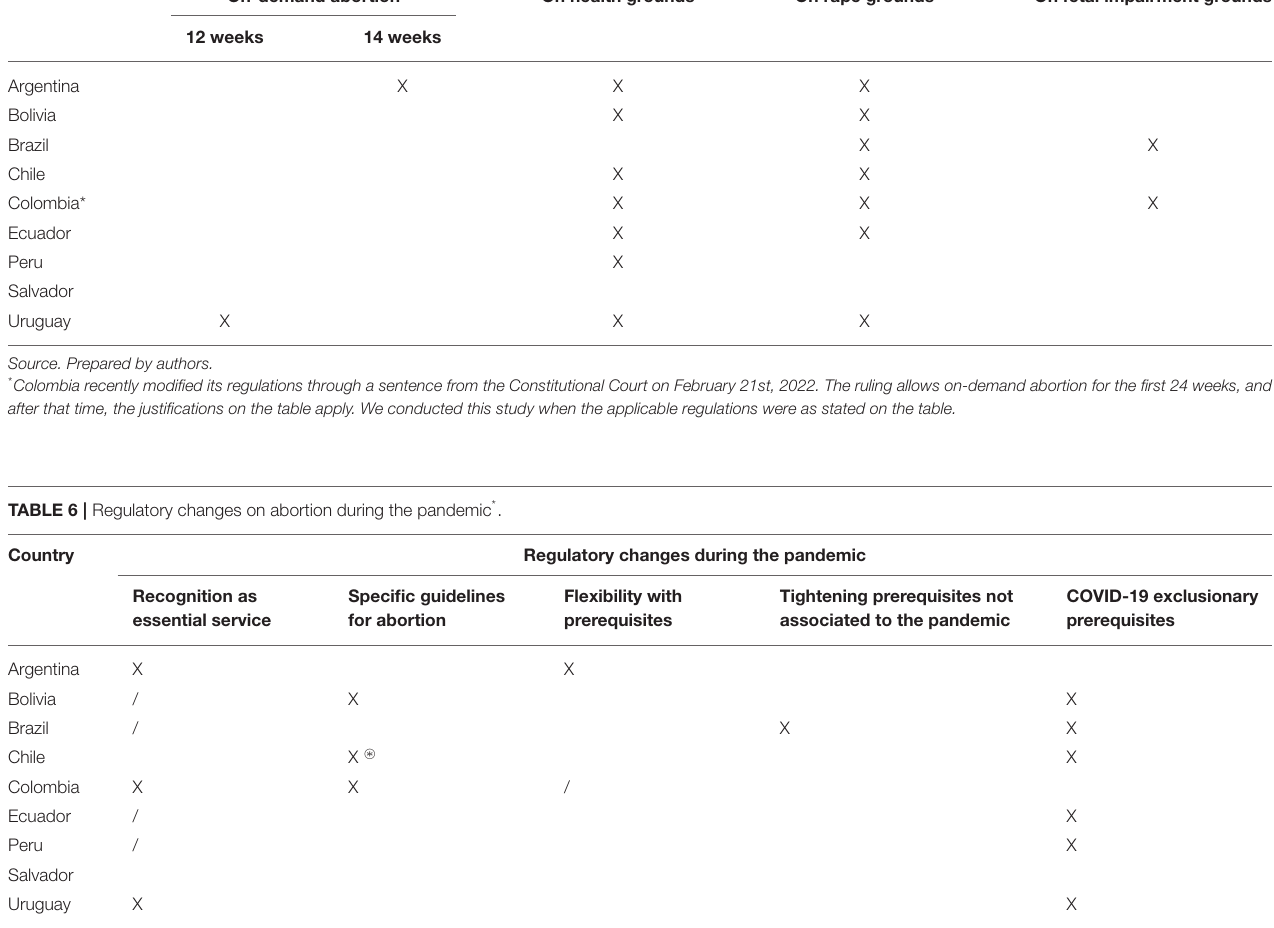
TABLE 5 | Abortion regulations during the pandemic. Country Abortion regulations On-demand abortion On health grounds On rape grounds